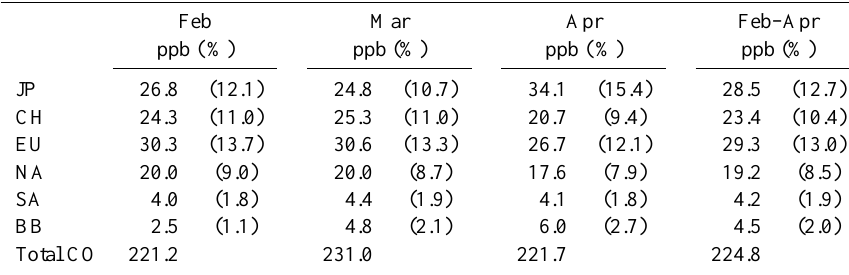
Fig. 9. Contributions of Japanese, Chinese and European industrial sources and transport from the stratosphere to hourly surface O 3 over Tokyo as a function of total modelled surface O 3 . Graphs are labelled with the correlation coefficient ( r ) and slope ( s ).